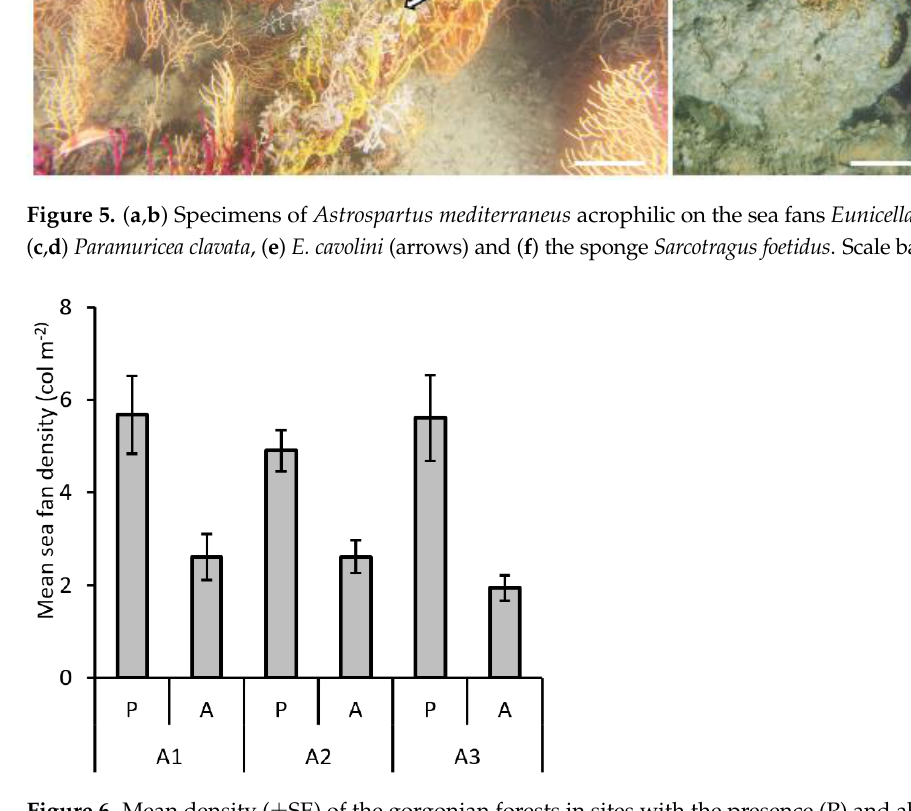
Figure 6. Mean density ( ± SE) of the gorgonian forests in sites with the presence (P) and absence (A) of Astrospartus mediterraneus in the three studied macro-areas. Table 2. PERMANOVA was performed on sea fan density of the sites where Astrospartus mediterra- neus was found in the investigated period. Bray-Curtis similarity index used for the resemblance matrix construction; permutation n = 9999. Significant values are in bold. df